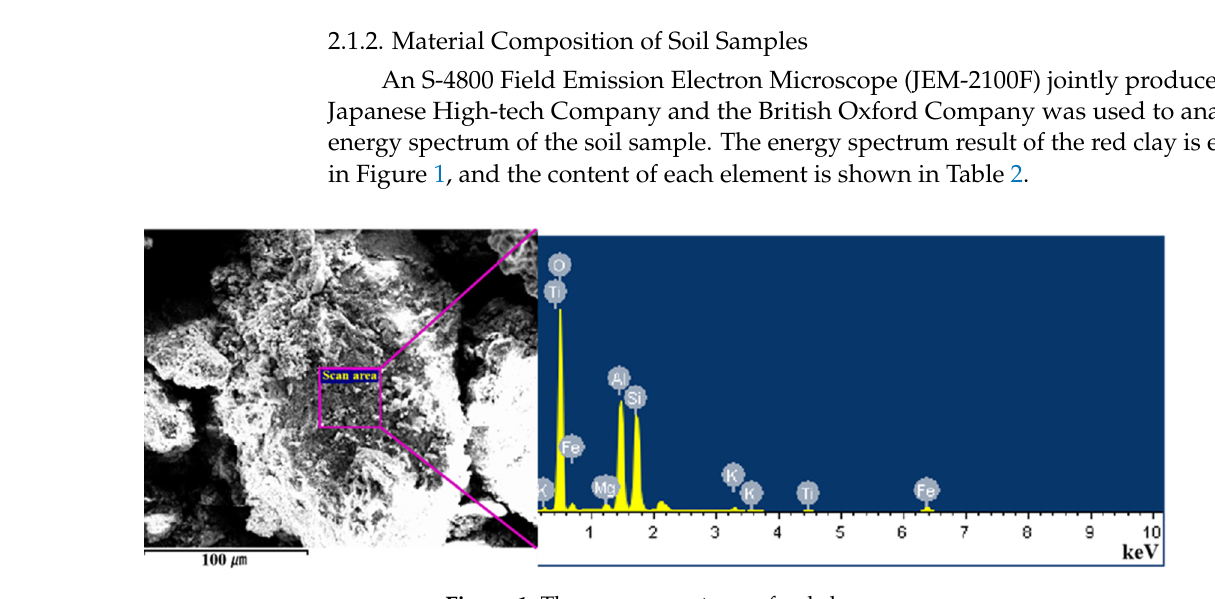
Figure 1. The energy spectrum of red clay. Table 2. Chemical composition of red clay.